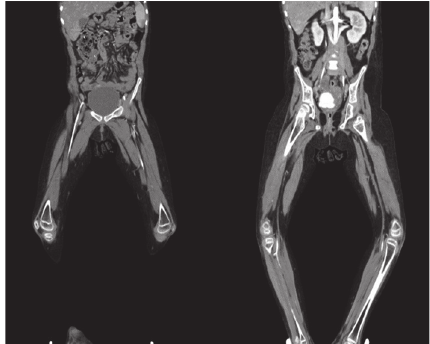
Figure 2: Contrast (white) shows weak blood flow in iliac, femoral, and popliteal